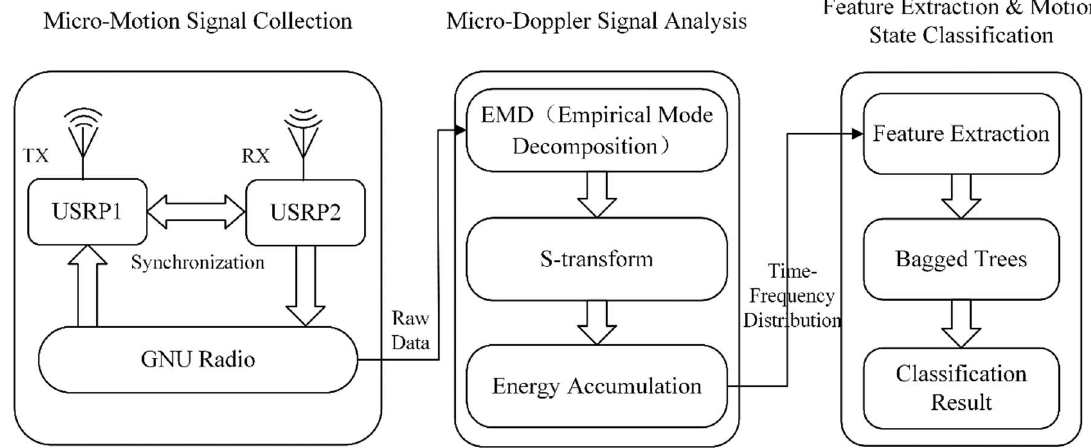
Figure 1. Architecture of the proposed system.